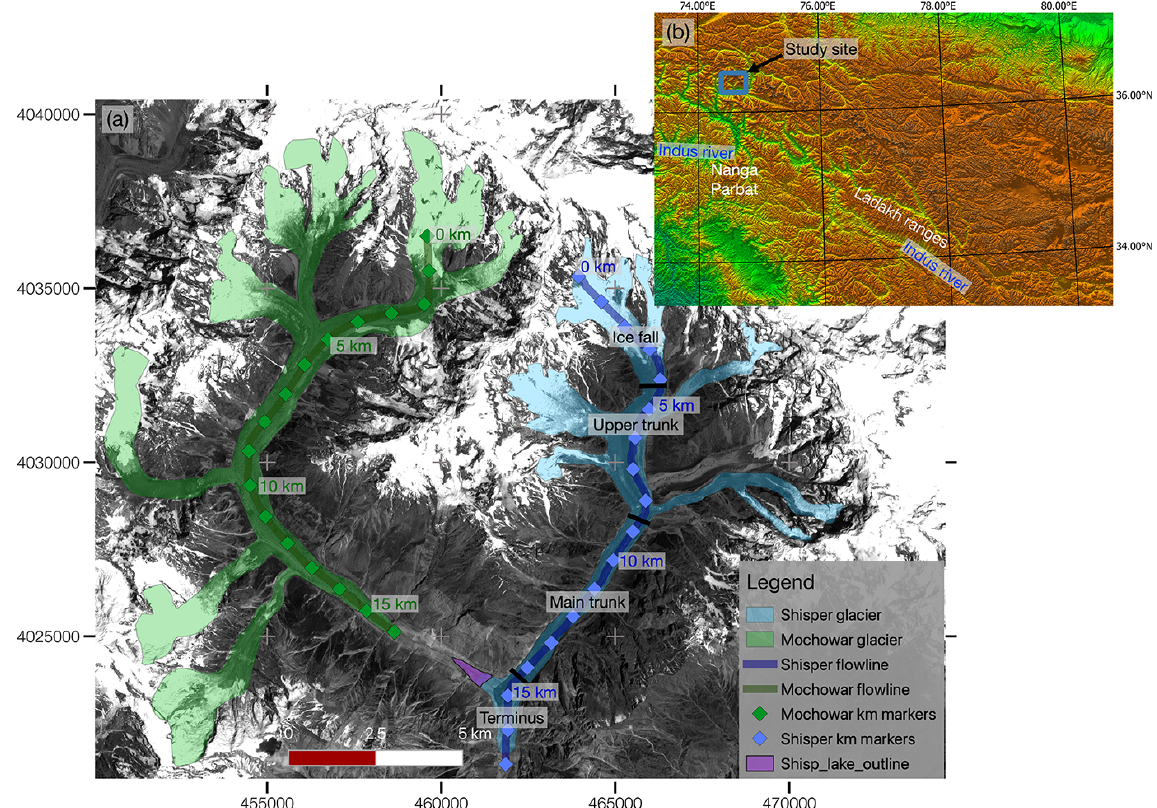
Figure 2. Overview of the study area. (a) Outlines of Mochowar (green) and Shisper (blue) glaciers with the location of the median flowlines used for analysis, and the maximum extent of the periglacial lake, overlaid on the Sentinel-2 optical image from 15 July 2018. The labels on Shisper glacier describe four zones identified as undergoing different dynamic processes during the surge. The icefall zone spans across the accumulation and ablation area of Shisper glaciers where surface slopes are steep (up to 45 ◦ ) and elevation > 3750ma.s.l. The upper trunk is within the ablation area and is where four tributaries merge with the main glacier. Surface elevations are comprised between 3750 and 3400ma.s.l., and the zone terminates just downflow from the last identifiable icefall along the profile. The main trunk is characterized by relatively uniform surface slope with no icefall or tributary junction and surface elevations range from 3400 and 2750ma.s.l. The terminus zone is below 2750ma.s.l. and represents the area that shows dynamic activity almost only linked to the advancing surge bulge. Coordinates are in meters and projected on zone 43N of the Universal Transverse Mercator (UTM) coordinate system. (b) Relief map of the Western Himalayan and Karakoram regions with notable geographic features for